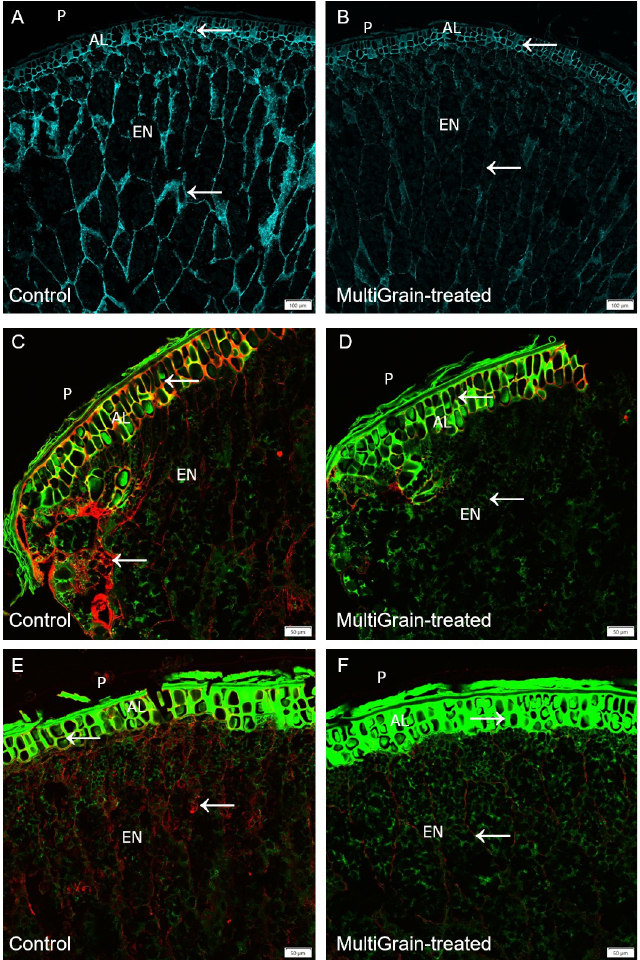
Fig 3. Confocal images of cross sections of whole barley grains. Section of samples incubated (A, C, E) with sodium acetate buffer (control) or (B, D, F) with MultiGrain for 3 hours at pH 5. The sections were subsequently (A, B) stained with Calcoflour White, or (C, D) incubated with the LM11 antibody detecting arabinoxylans with low degree of branching and the red-fluorescence labelled secondary antibody, or (E, F) incubated with the antibody detecting (1,3), (1,4)- β -glucan and the red-fluorescence labelled secondary antibody. (A, B) Light blue signal indicates cellulose and other β -1,4-linked glucans. Red signal indicates (C, D) arabinoxylans, (E, F) β -glucans and the green signal indicates autofluorescence. P = pericarp; AL = aleurone; EN = starchy endosperm. Arrows point to sites where the fluorescence signal due to staining or immunolabelling is present and removed following treatment with MultiGrain. (A, B) Scale bar = 100 μ m. (C-F) Scale bar = 50 μ